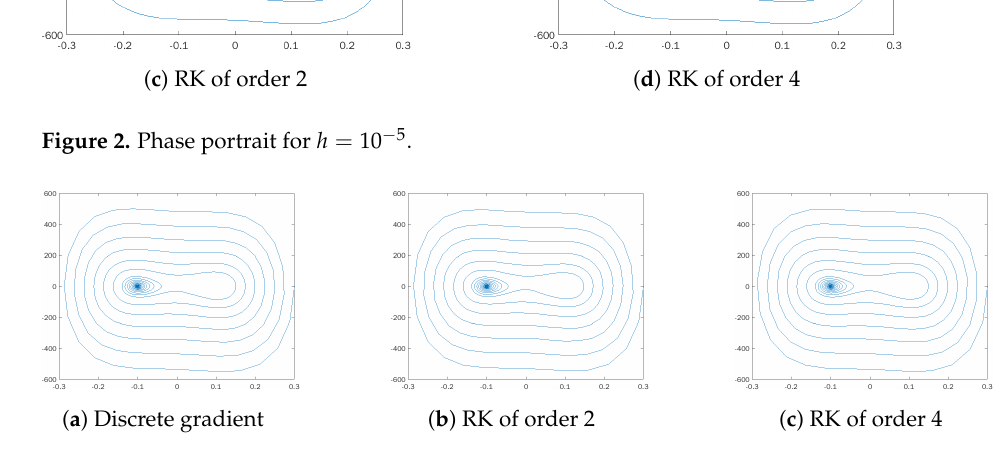
Figure 3. Phase portrait for h = 10 − 4